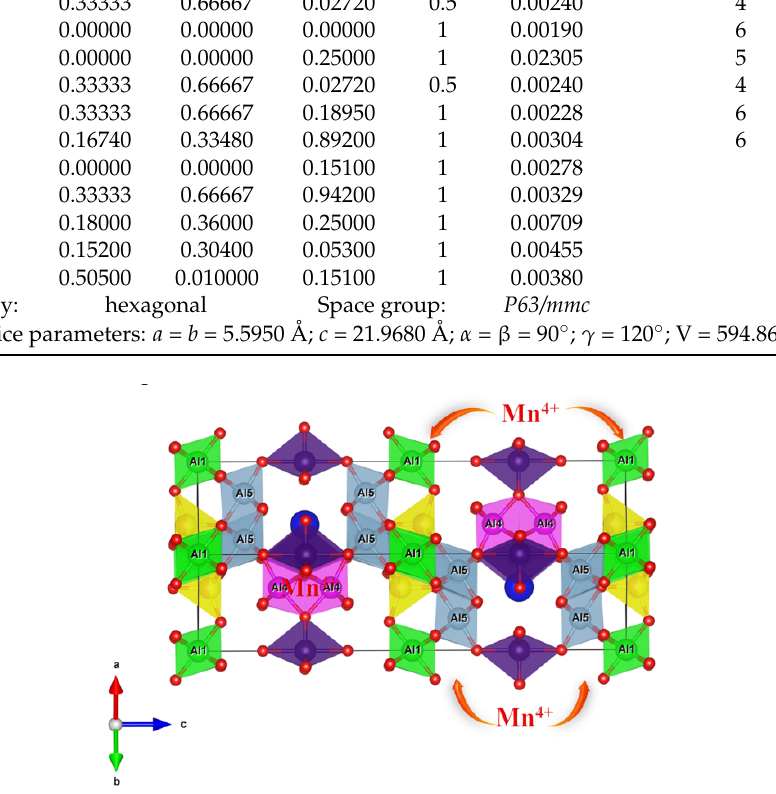
Figure 2. The crystal structure of LaMgAl 11 O 19 and the octahedral AlO 6 ligands.